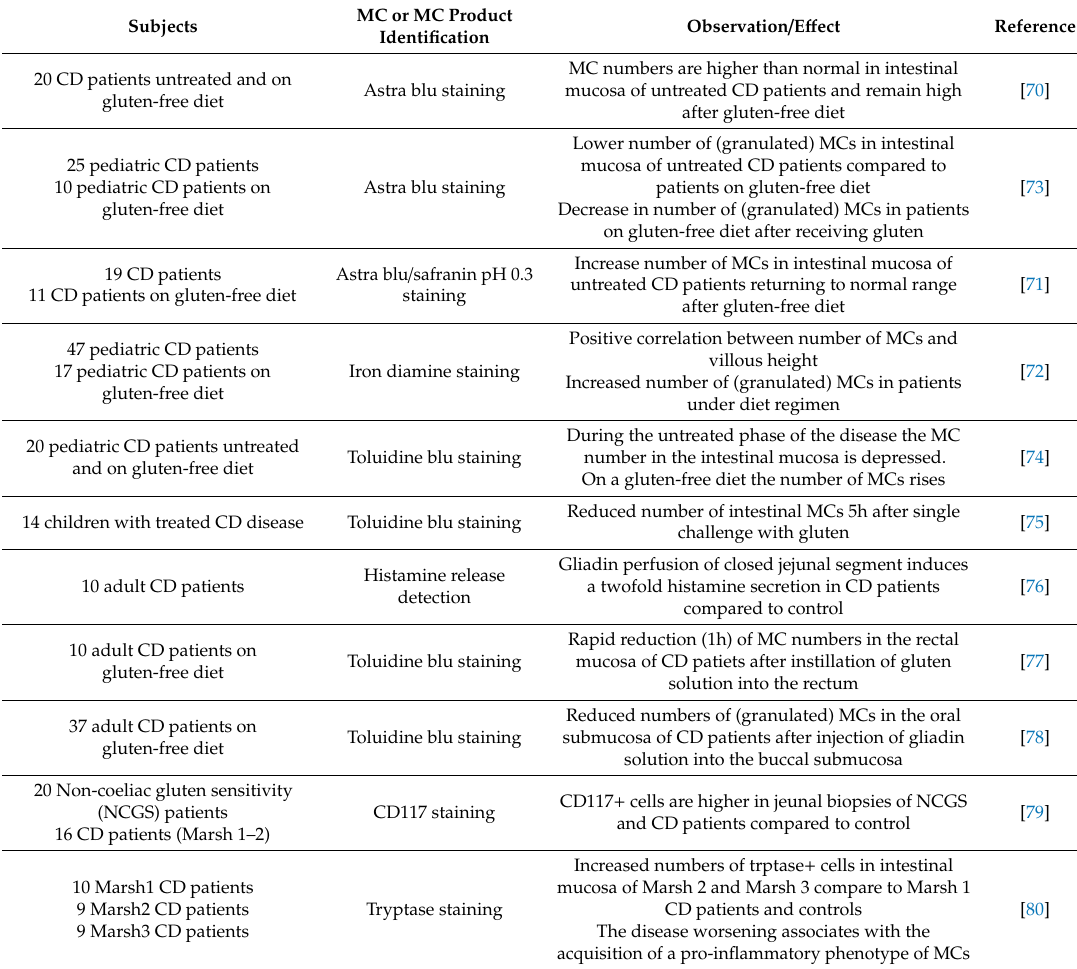
Table 3. MC implication in coeliac disease